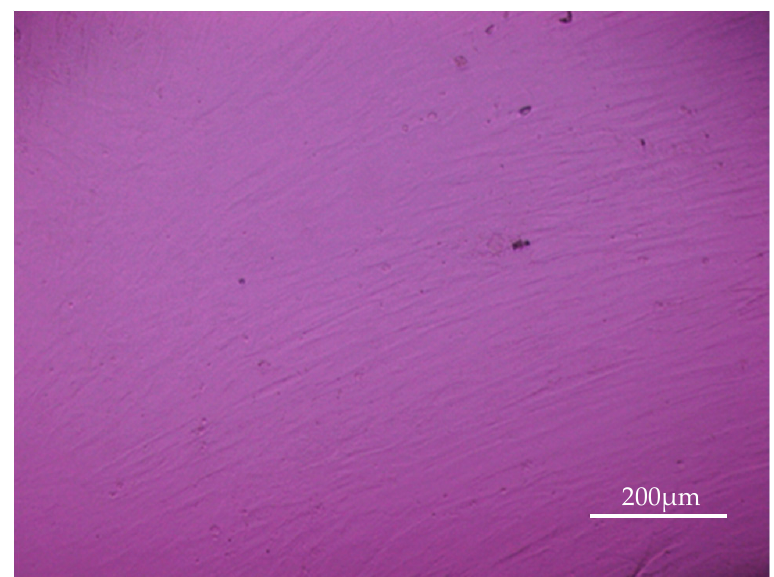
Figure 7. Human osteoblasts were cultivated from human bone marrow which was collected during surgery from patients who required an autologous bone graft. Cells were cultivated in osteoblast growth medium and after 10–14 days homogenous cell layers were seen. Osteoblasts were used for a maximum of two passages.